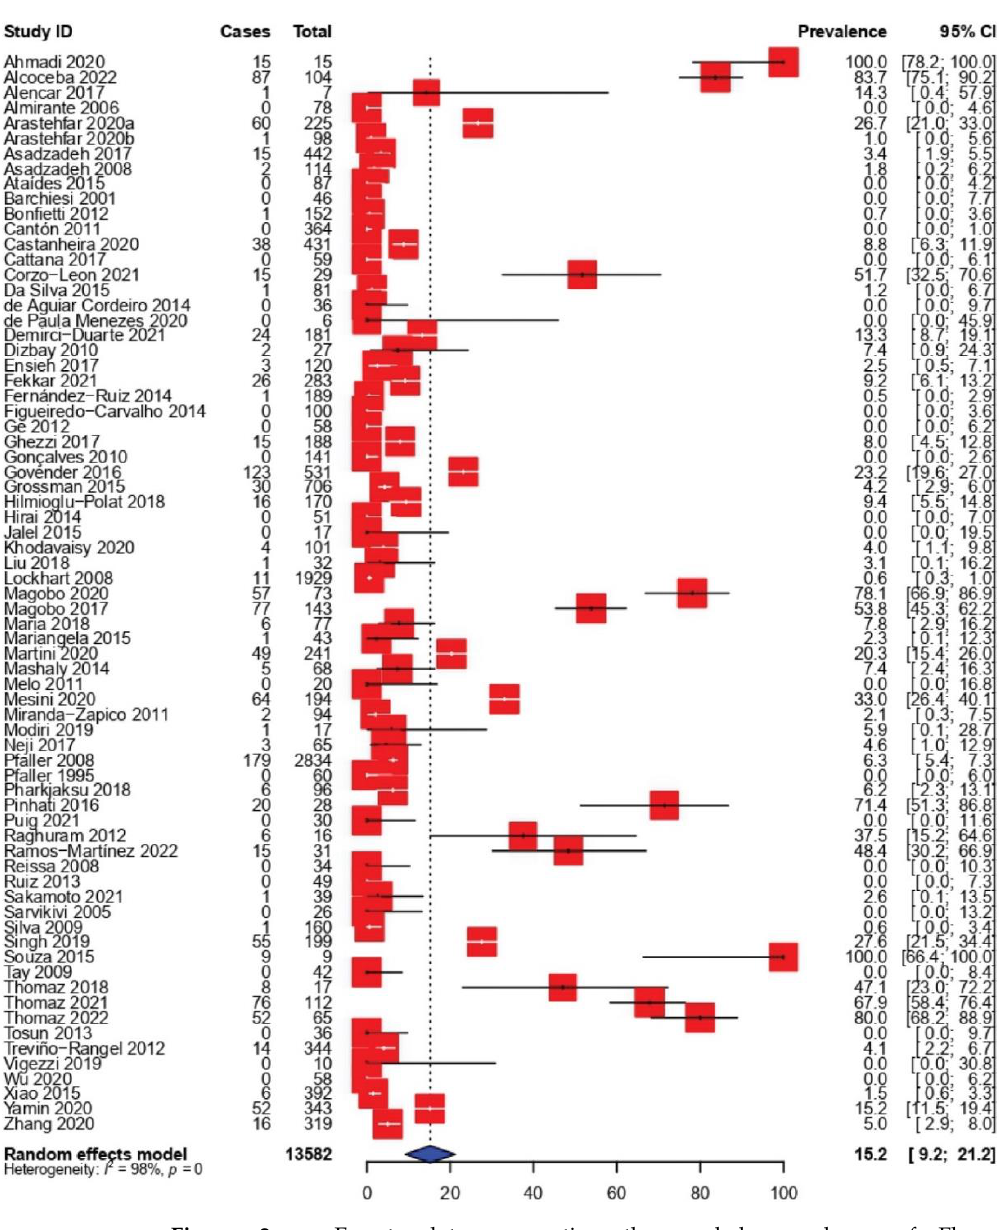
Figure 2. Forest plot representing the pooled prevalence of Fluconazole-Resistant Candida parapsilosis isolates.